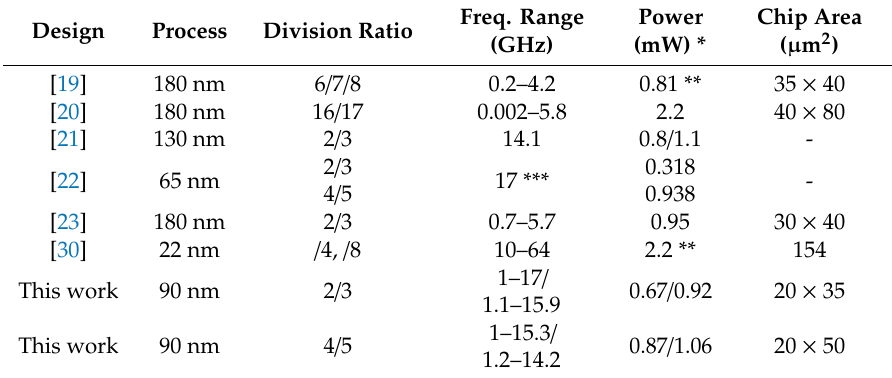
Table 1. Comparison with previous